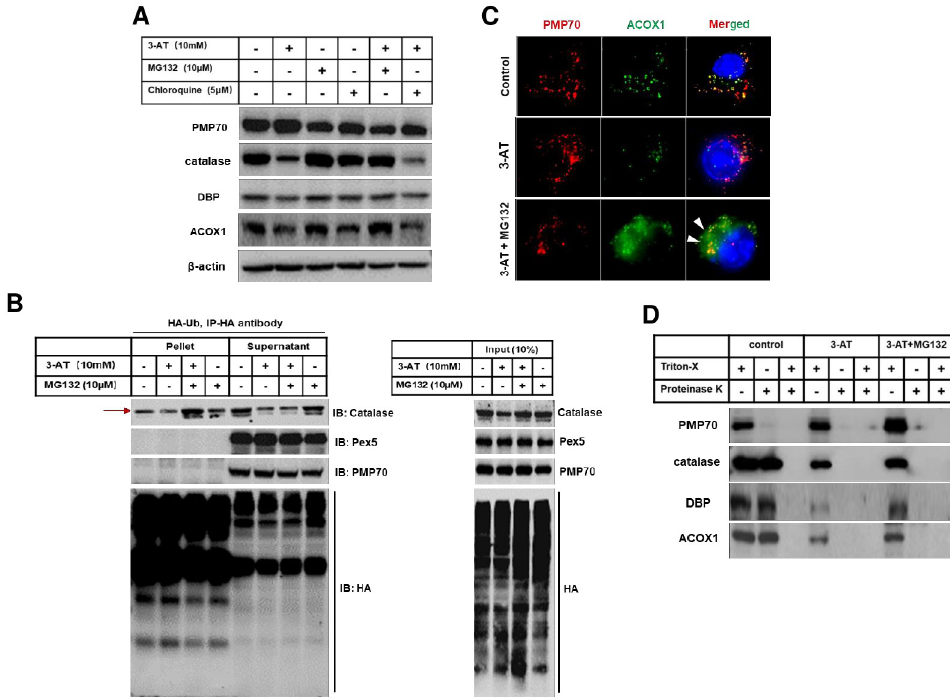
Fig 3. 3-AT induced peroxisome leakage and promoted the ubiquitin mediated proteasomal degradation of peroxisomal matrix proteins. (A) Cells were treated with 3-AT (10 mM), MG132 (10 μ M), chloroquine (5 μ M), combination of 3-AT and MG132, 3-AT or chloroquine for 24 h and followed by immunoblotting. (B) Cells were transfected with HA-Ub plasmid for 12 h. Cells were then treated with 3-AT, MG132 or combination of 3-AT and MG132 for additional 24 h. Cell lysates were then subjected for immunoprecipitation and immunoblotting. (C) Cells were treated with 3-AT alone, or combination of 3-AT and MG132 for additional 24 h and immunostaining was performed with anti-PMP70 (red) and anti-ACOX1 (green). (D) Cells were treated as in (C) , followed by Proteinase K protection assay, and immunoblotting for PMP70, Catalase, DBP and ACOX1.